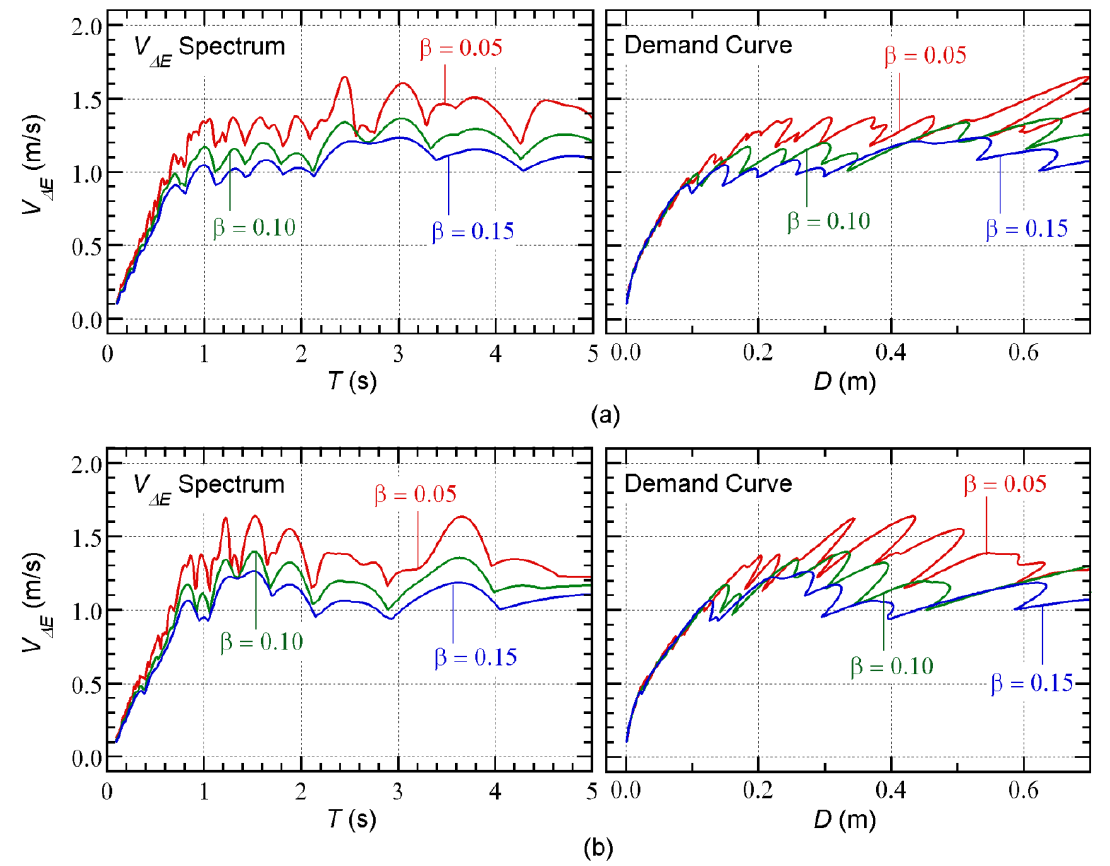
Figure 7. Demand curve of input ground motions: ( a ) Art-L series; ( b ) Art-S series. On the left of Figure 7a, the calculated smallest when = 0.15. The demand curves are compared on the right of Figure 7a. The three demand curves are almost identical when ( )